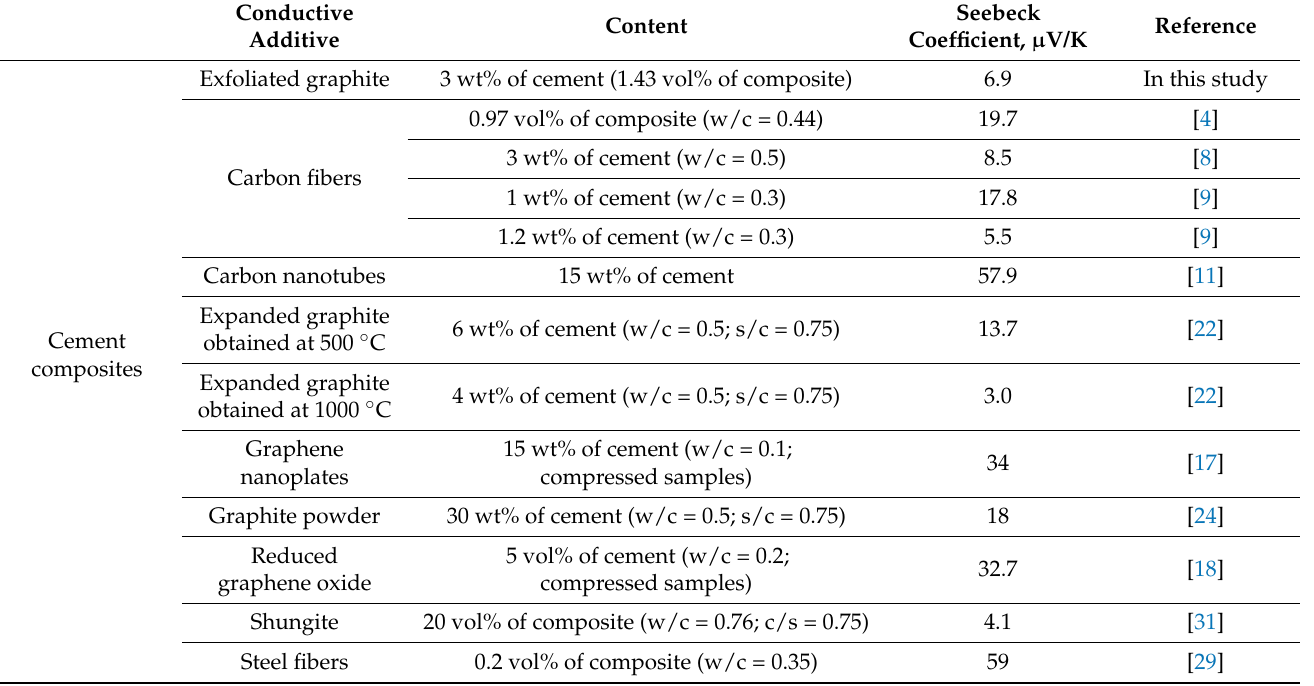
Table 4. Seebeck coefficients of cement composites with different conductive